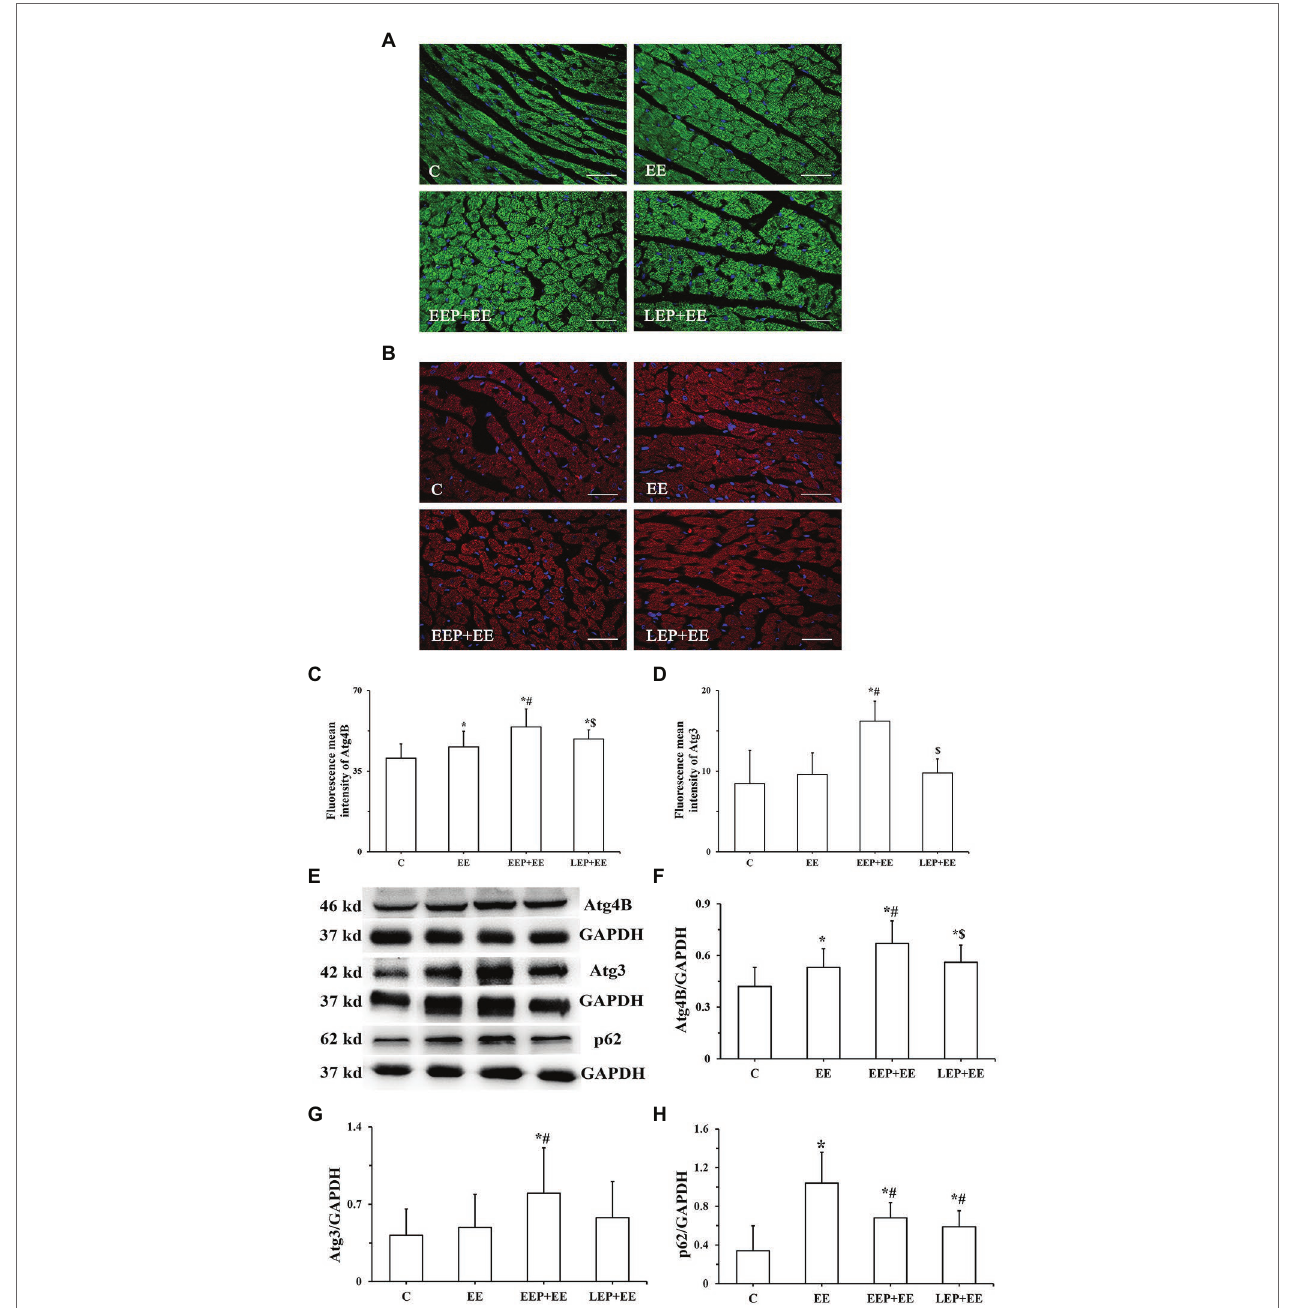
FIGURE 9 | Expression of Atg4B, Atg3, and p62 levels during EP alleviated myocardial injury induced by exhaustive exercise. (A) Immunofluorescence staining of Atg4B in cardiomyocytes (bar = 100 μ m). Atg4B was stained green and had a scattered distribution in group C. (B) Immunofluorescence staining of Atg3 in cardiomyocytes (bar = 100 μ m). Atg3 was stained red and had a scattered distribution in group C. (C) Fluorescence mean intensity of Atg4B immunofluorescent staining. (D) Fluorescence mean intensity of Atg3 immunofluorescent staining. (E) Western blot of Atg4B, Atg3, and p62. (F) Western blot analysis of Atg4B in different groups. (G) Western blot analysis of Atg3 in different groups. (H) Western blot analysis of p62 in different groups. * p < 0.05 vs. group C; # p < 0.05 vs. group EE; and $ p < 0.05 vs. group EEP +